Question: Briefly state, in one sentence, what is plotted here.
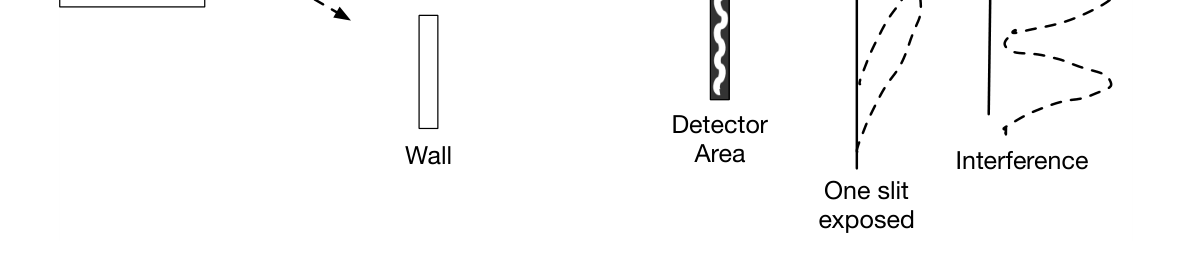
Answer: The fundamental essence of what makes quantum computing different from classical computing rests in the property of quantum entanglement, which results from the interference that occurs when quantum systems are composed. In this famous two-slit thought experiment Feynman et al. (2010), the behavior of electrons is completely predictable when the beam of electrons is allowed to pass through just one slit, but when both slits are exposed, the behavior of the composite system is no longer a decomposable function of the individual systems. If we model each individual system in terms of a probability distribution where the electron might be detected, the behavior of the combined system violates the total law of probability, which states that the probability P(E1 + E2) = P(E1) + P(E2), where P(Ei) is the probability of detecting an electron through slit i. This paradoxical behavior necessitated the use of complex numbers in modeling quantum behavior, and thus probabilistic events